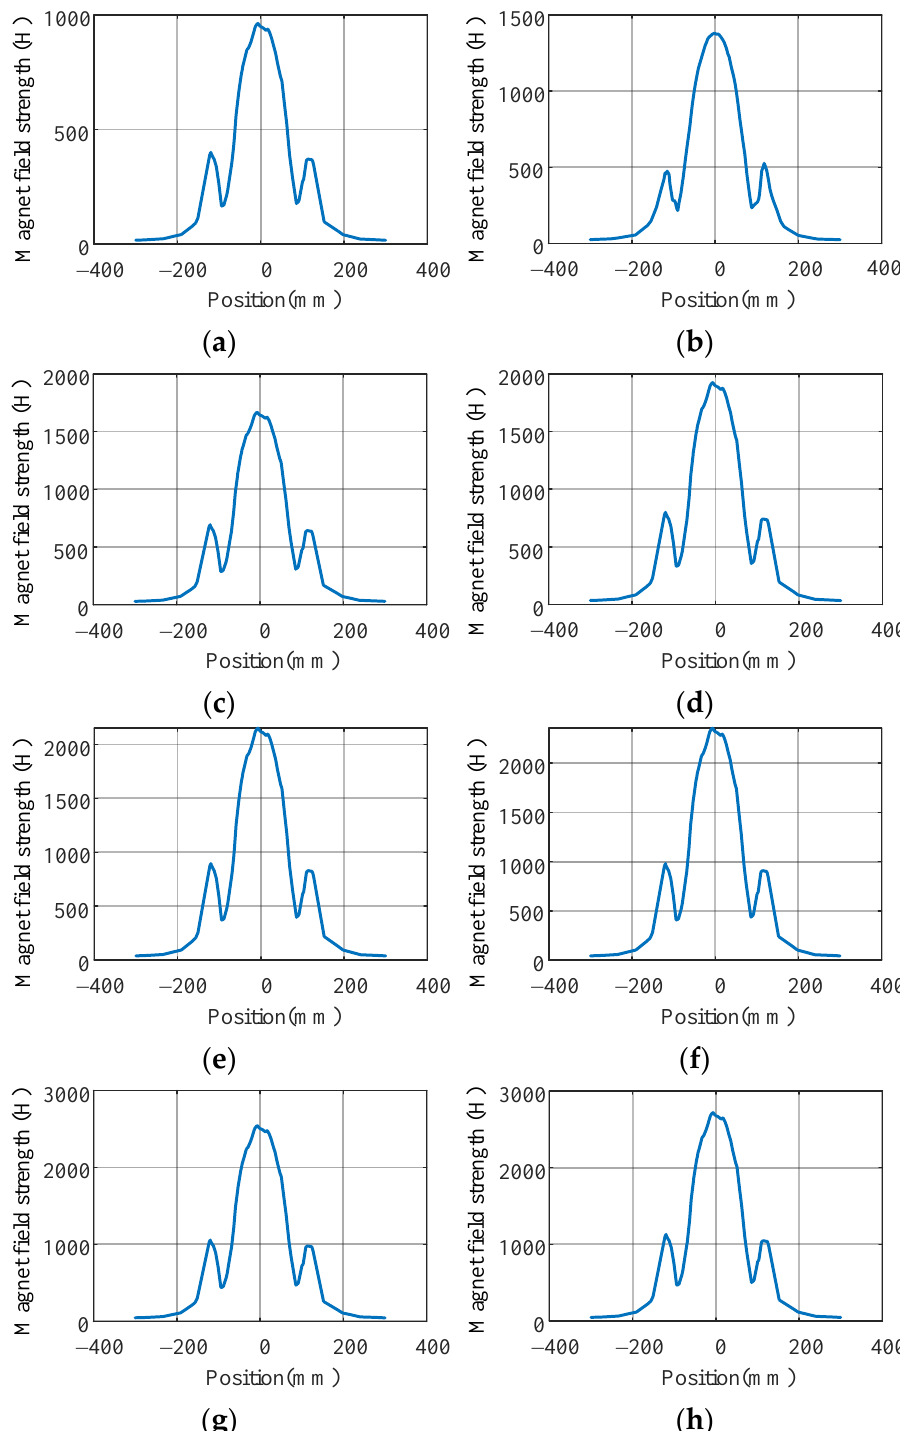
Figure A3. Magnetic field strength curves with different input powers. ( a ) 5 mm. ( b ) 10 mm. ( c ) 15 mm. ( d ) 20 mm. ( e ) 25 mm. ( f ) 30 mm. ( g ) 35 mm. ( h ) 40 mm.